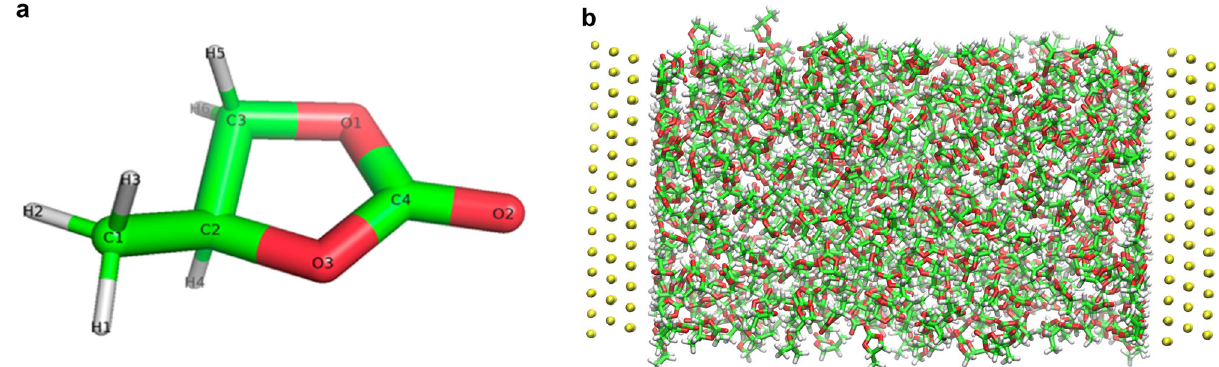
Fig. 3 Illustrations of molecular dynamics simulations for PC. a Molecular structure of PC. b Representative con fi guration of PC con fi ned between gold slabs (gray spheres). The distance between the gold layers in direct contact with PC is 6.5 nm. The oxygen, carbon, and hydrogen atoms in PC are colored in red, green, and white, respectively. The snapshot corresponds to the y – z plane, with the z vector being perpendicular to the gold slabs.